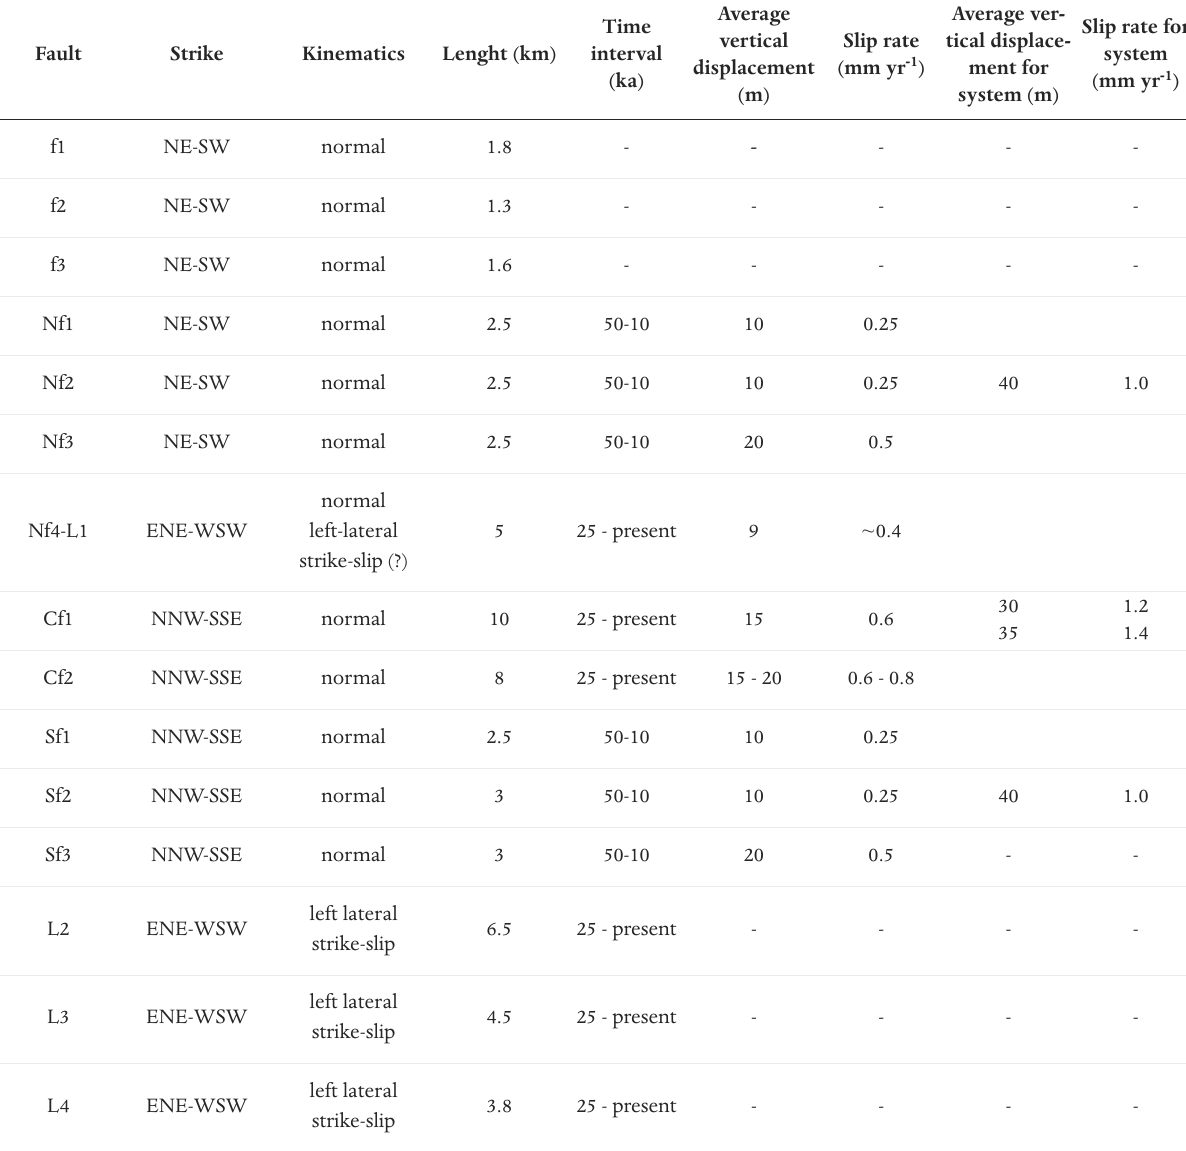
Table 1. Summary of fault parameters, vertical displacement, age and slip rate of dip-slip fault for different inferred time